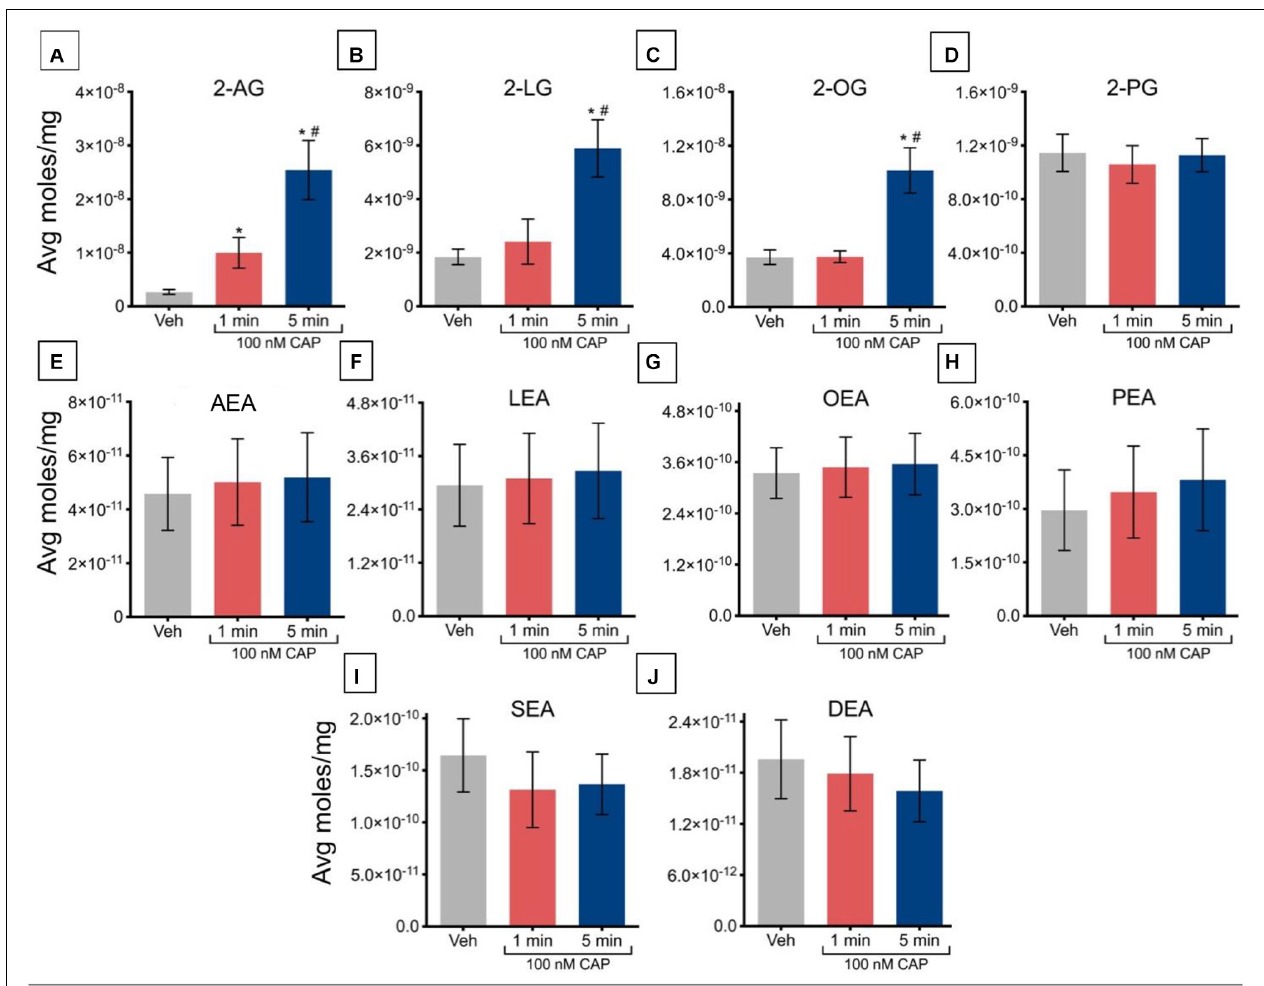
FIGURE 1 | Changes in lipid levels of 2-acyl glycerols (A–D) and N -acyl ethanolamines (E–J) after TRPV1-HEK293 cells incubated in 100 nM capsaicin (CAP) for 1 min or 5 min. Significant changes in lipid levels when comparing capsaicin-induced changes after 1 min or 5 min to vehicle is indicated by * ( p ≤ 0.05). Significant changes in lipid levels when comparing capsaicin-induced changes after 1 min of incubation vs. 5 min of incubation is indicated by # ( p ≤ 0.05). Data were averaged over 12 total data points per condition ( n = 3 individual experiments) and presented as average moles/mg ( y -axis).